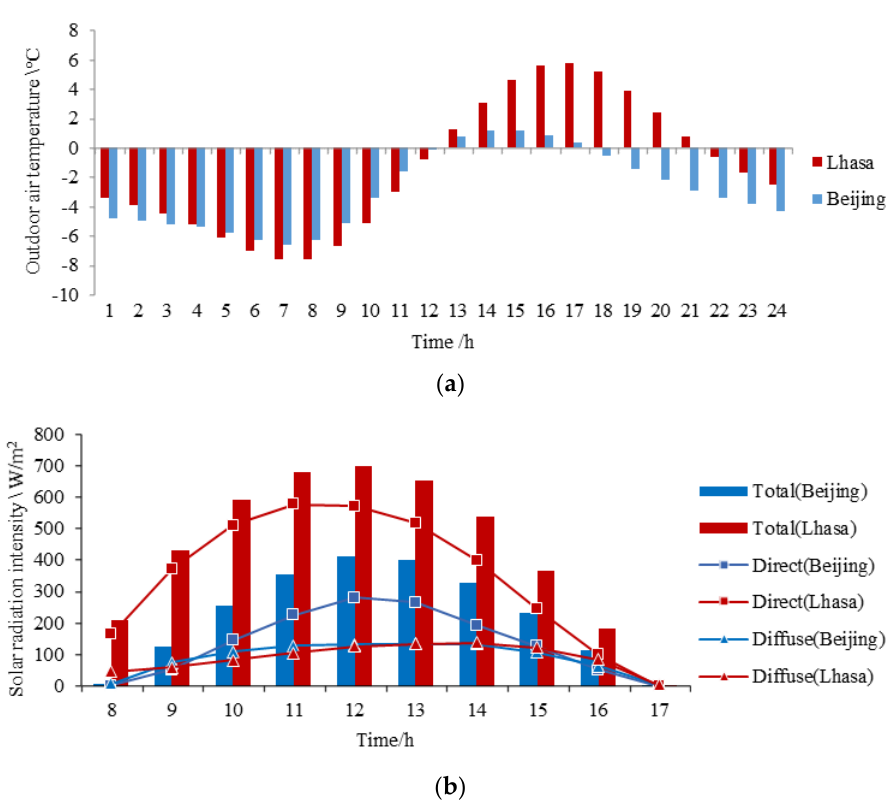
Figure 12. The typical weather day: ( a ) hourly outdoor air temperature; ( b ) hourly solar radiation intensity.